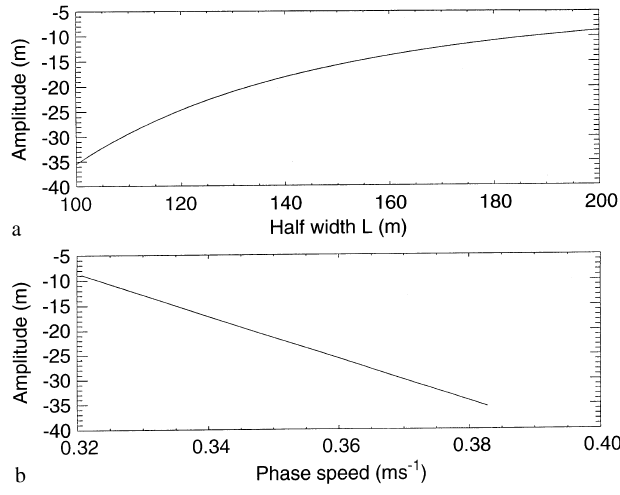
Fig. 16a, b. KdV predictions of a soliton half width L and b phase speed c for waves with given amplitudes, for the stratification and modes shown in Figs. 10